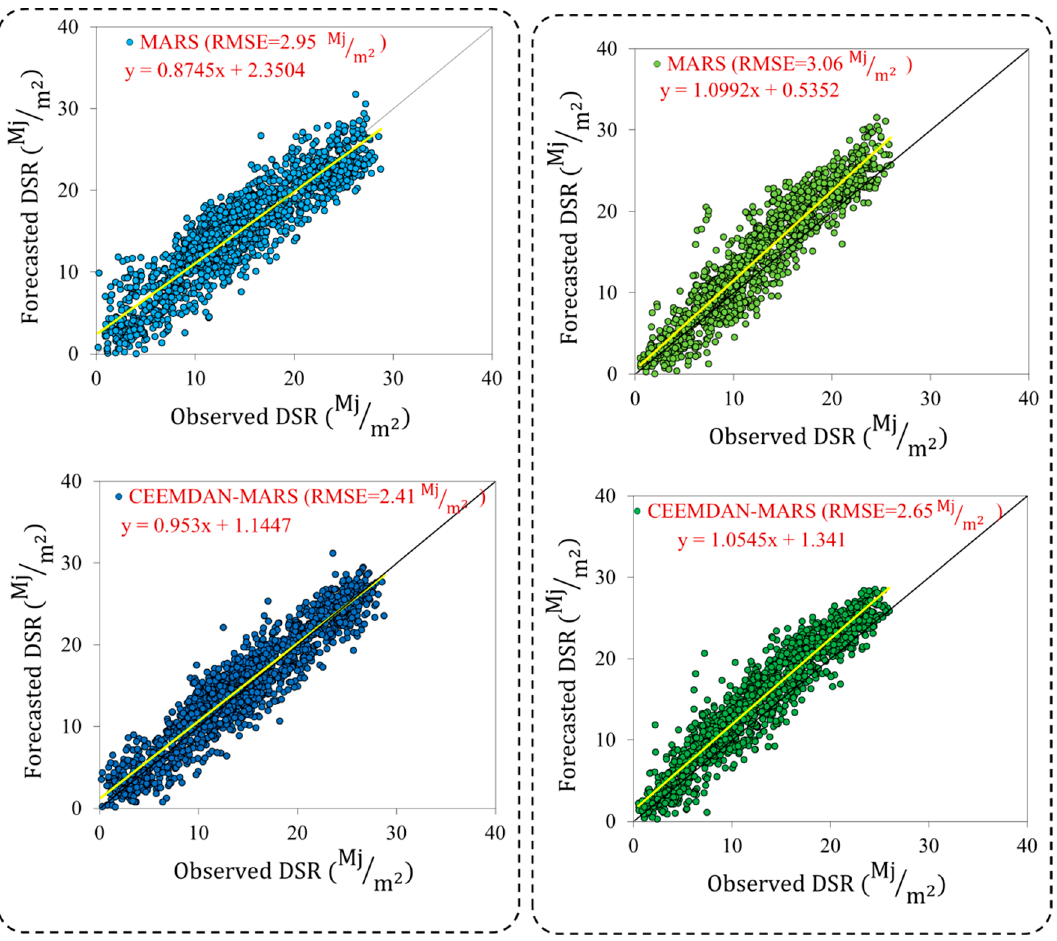
Figure 6. Scatterplots of observed and forecasted DSR using the MARS and CEEMDAN-MARS models in the validation phase at Busan (blue color) and Incheon (Green color) stations.